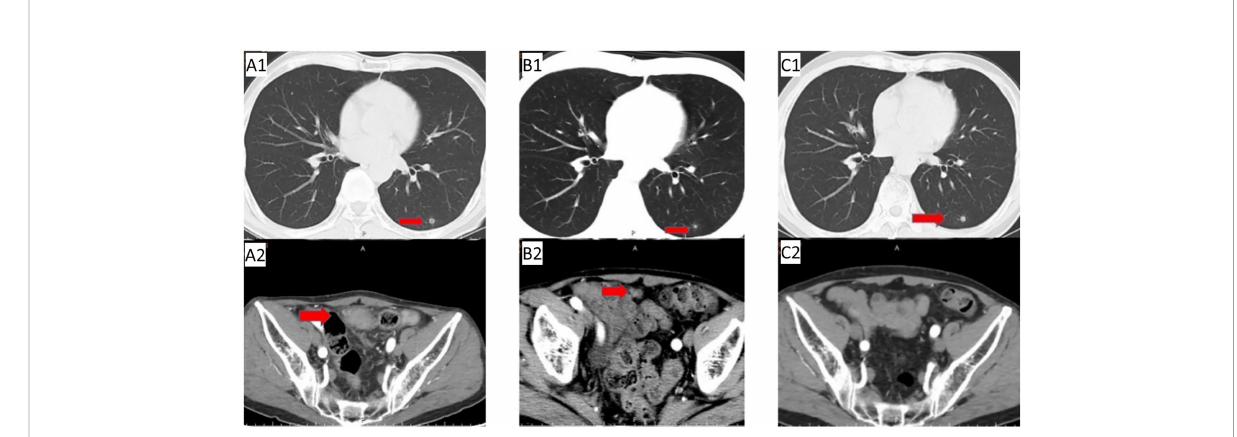
FIGURE 1 First-line treatment: (A1/A2) Baseline CT before fi rst-line treatment; (B1/B2) CT after 2 cycles showed left lung nodules similar to before, pelvic metastases were signi fi cantly reduced; (C1/C2) follow-up CT on May 29, 2019 showed slightly enlarged left lung nodules, no pelvic metastases were